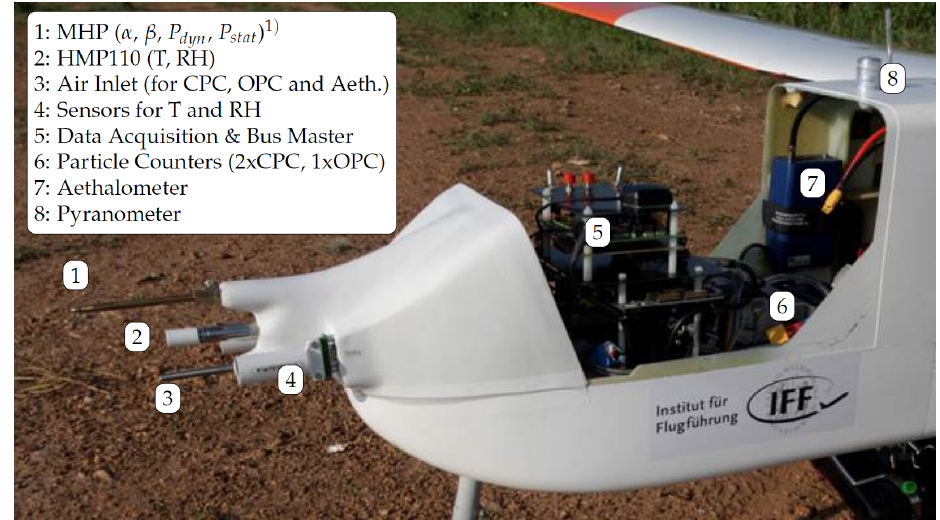
Figure 1. Payload bay of ALADINA with measurement equipment. 1 MHP: multi-hole probe, α : angle of attack, β : angle of